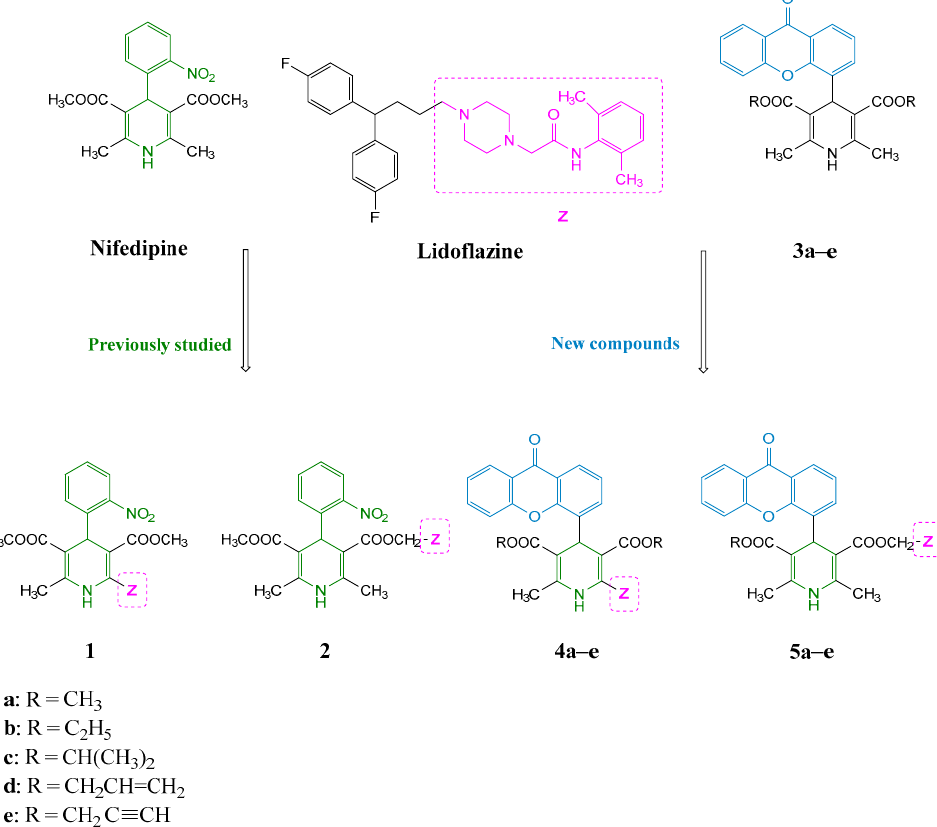
Figure 2. Design strategy for the studied compounds 4a – e and 5a – e .